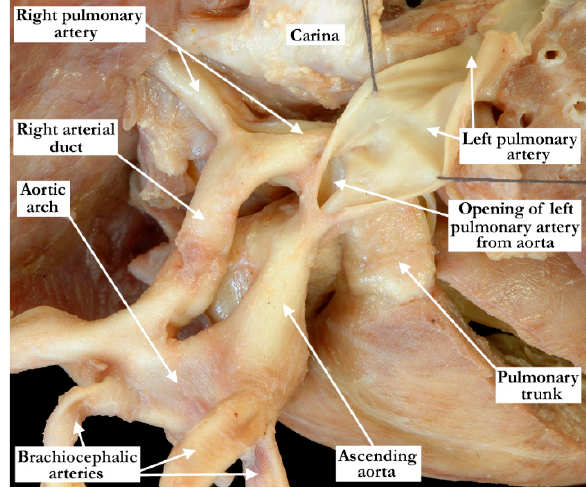
Figure 8. In this superior view, the aorta, right aortic arch and the pulmonary trunk have been folded forward and slightly rightward to show the origin of the left pulmonary artery from the ascending aorta and how it crosses the origin of the right pulmonary artery, which arose in the usual fashion from the pulmonary trunk. The patent arterial duct is easily appreciated extending between the right aortic arch and right pulmonary artery.